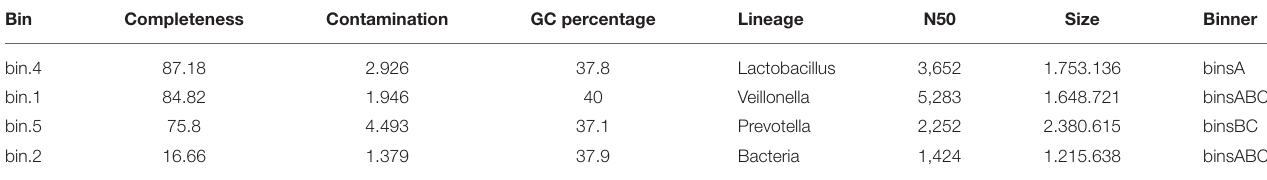
TABLE 4 | Basic metrics for the generated bacterial bins. Bin